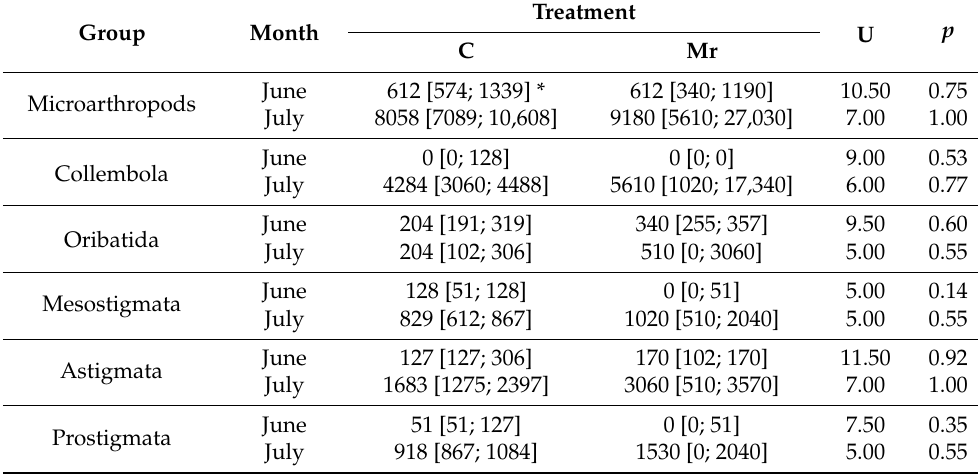
Table 4. Results of comparative analysis of the density of soil microarthropods (ind./m 2 ) in the plots out taking into account only colonized plants in M. robertsii treatment and uncolonized plants in the control in 2020 (Mann–Whitney